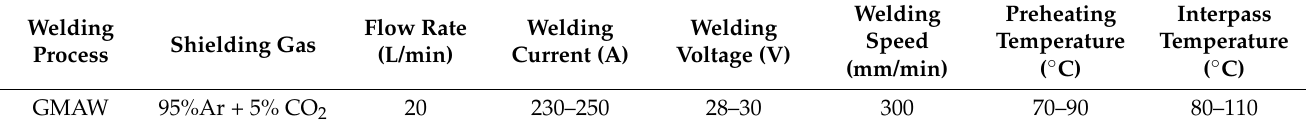
Table 2. Welding Table 2. Welding parameters.